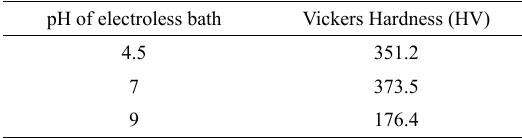
Table 13. The effect of pH on the hardness of composite